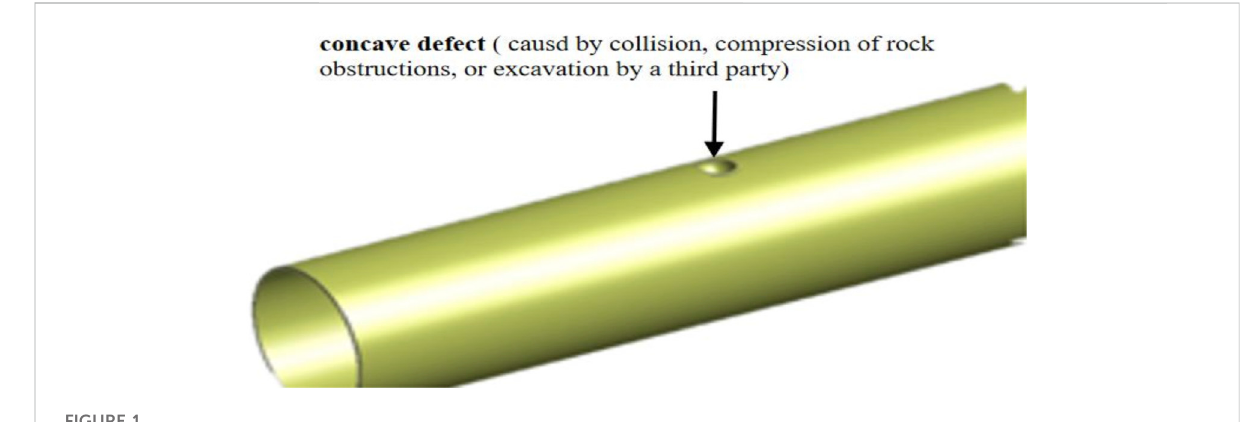
FIGURE 1 Schematic diagram of aconcave